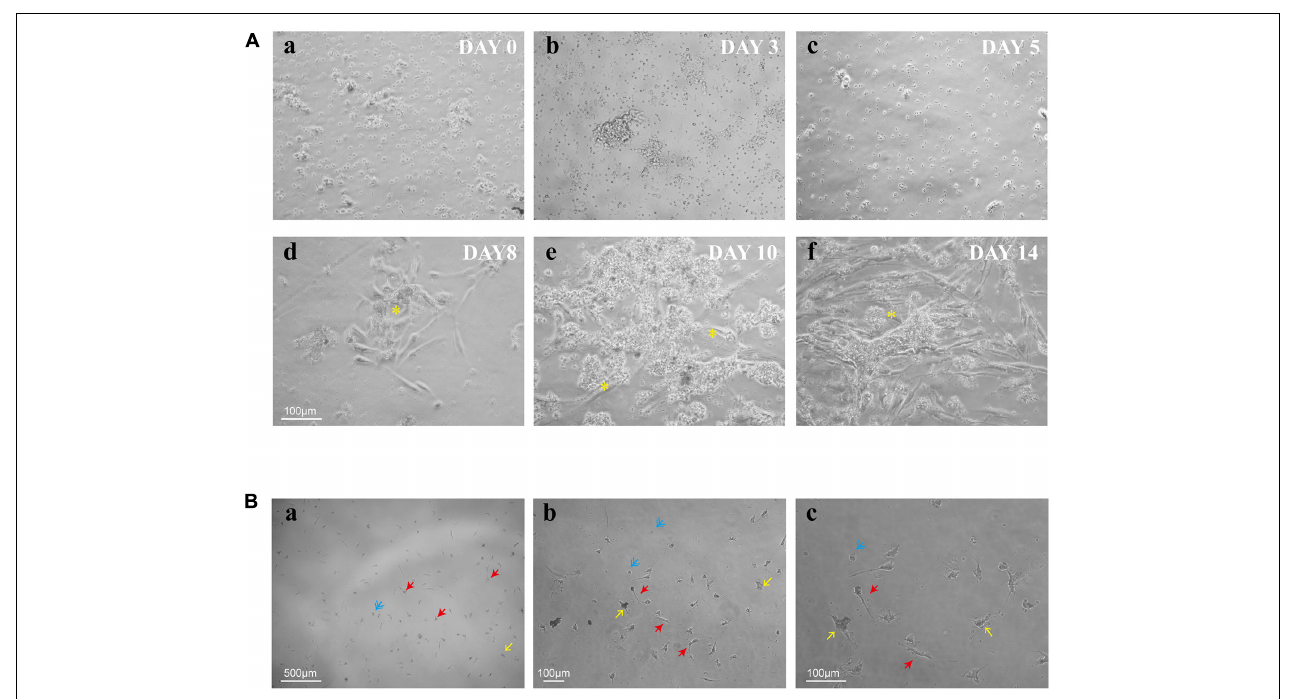
FIGURE 2 | Timeline for the culture of retinal microglia. (A) Representative phase-contrast microscopy images of retinal mixed glial culture seeded on T75 flasks at a density of 3–4 × 10 5 cells/cm 2 (a). The first media change was made on day 3 after cell adherent (b). Small granules of cell debris presenting as black dots were shown up on the plate surface on day 5 (c). Cells grew and emerged to clusters ( ∗ ) on day 8 and attached to Müller cells (d). Müller cells were spread all over the bottom of the plate, and retinal microglia were shown as small bright rounded cells which loosely adhered to Müller cells (e,f). (B) Shaken retinal microglia were shown multiple cell morphologies (blue: rounded; yellow: ameboid; and red: ramified). Scale bar: 500 µ m in a; 100 µ m in b; and 100 µ m in